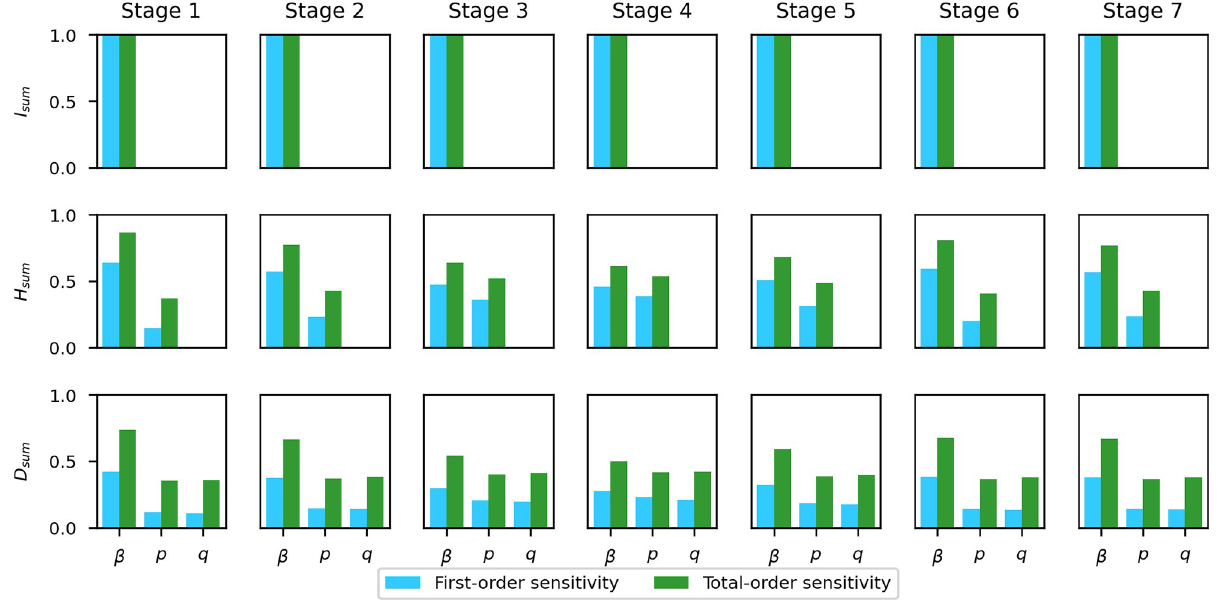
Fig 5. Sensitivity of each quantity of interest ( I sum , H sum , D sum ) with respect to each parameter ( β , p , q ). The parameter β is the most important parameter for all three quantities of interest in every stage of the pandemic. The parameter p has no influence on I on I sum or H sum